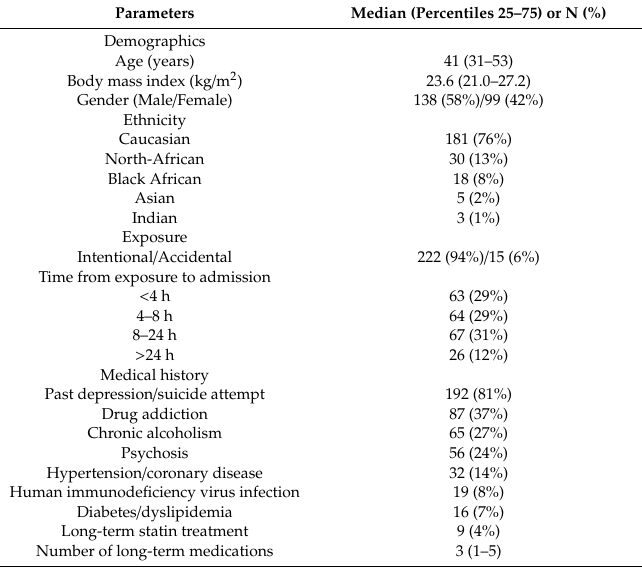
Table 1. Characteristics of the study